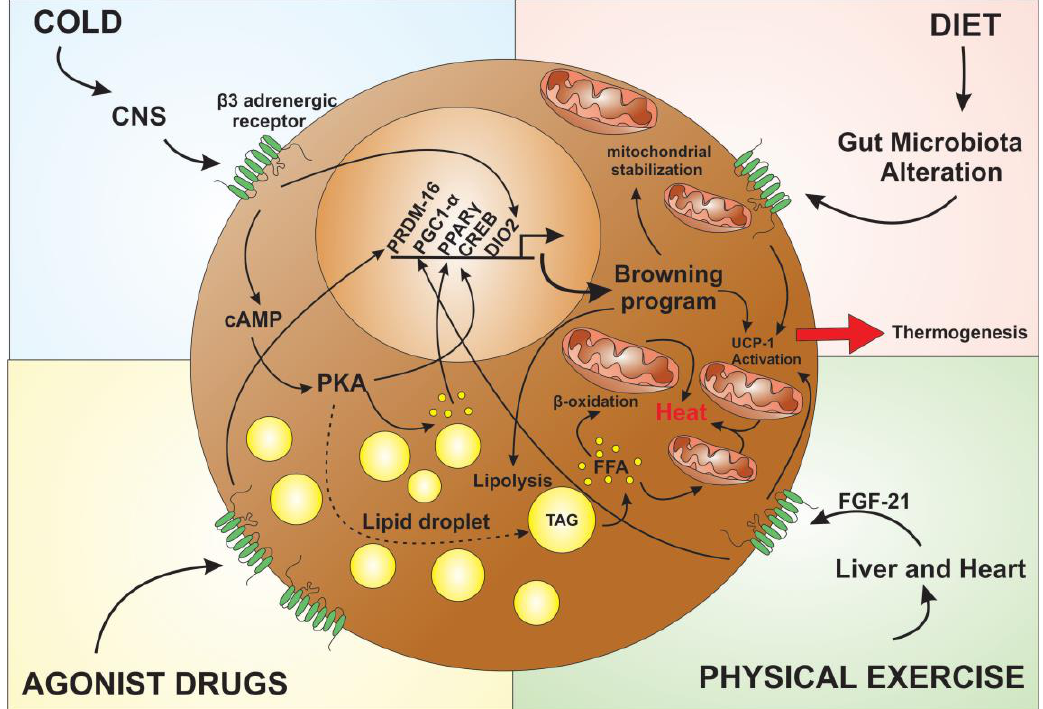
Figure 3. External agents capable of inducing the browning process in adipose tissue. β 3 receptor activation regulate the transcription and activation of genes linked to mitochondrial activity and fat storage. The exposure to excessive cold induces release of catecholamines by the central nervous system (CNS), which will act on β 3 adrenergic receptors on adipocytes initiating the signaling cascade. Activation of cAMP through the binding of catecholamines at adipocytes receptors will activate protein kinase A (PKA), which will then induce lipid droplet lipolysis. This lipolysis will induce thermogenesis by β oxidation in the mitochondria, as well as activation of the UCP1 protein, and the activation of important genes linked to the browning process like peroxisome proliferator-activated receptor γ (PPAR γ ), cAMP-response element binding protein (CREB) and Type II iodothyronine deiodinase (DIO2). Similarly to the cold, the food also influences the thermogenic process by the production of metabolites by the gut microbiota that will act both indirectly, acting in the liver, and directly in the adipocytes inducing the activation of the UCP1 protein in the mitochondria. The liver and heart act in the process being regulated by the practice of physical exercises increasing the release of fibroblast growth factor 21 (FGF-21), which will regulate the activity of the gene PGC1. In order to enhancer the process, several agonist drugs are also used, both in the increase of β 3 adrenergic receptors expression and in the regulation of genes like PR (PRD1-BF1-RIZ1 homologous)–domain containing 16 PRDM16, acting in the regulation of expression and activation of UCP1, which will then potentiate the thermogenic process in the adipocytes, characterizing the browning